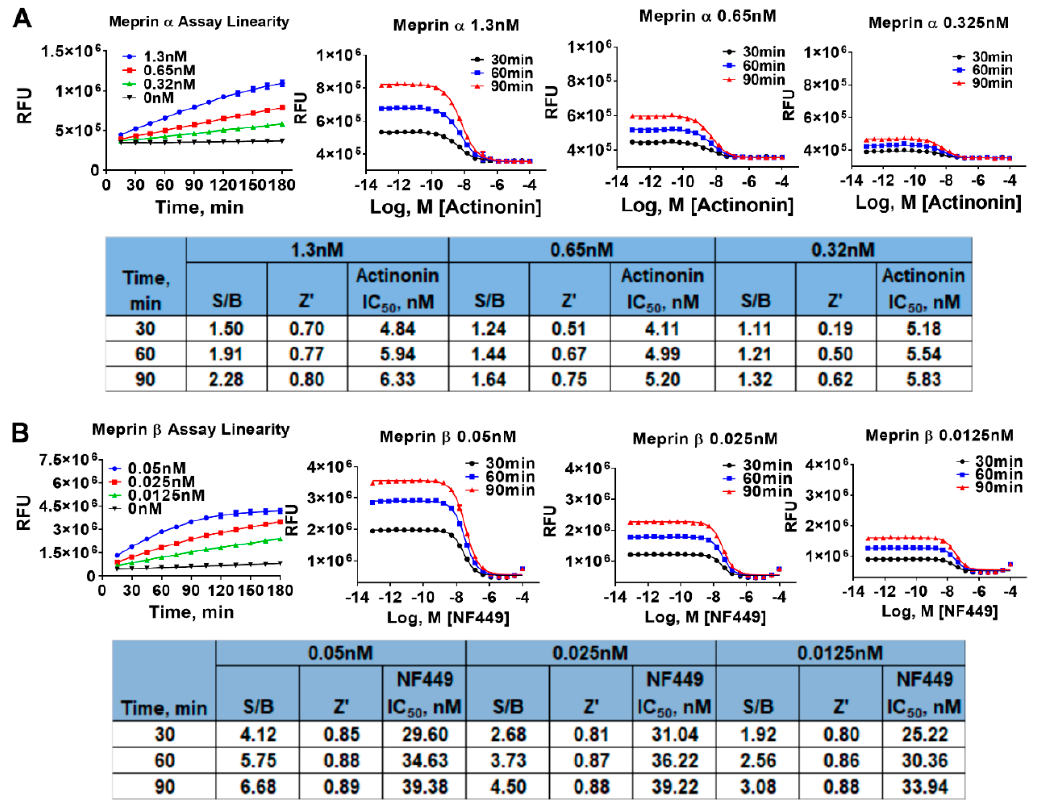
Figure 3. Enzyme concentration and time of reaction optimization experiments in 1536 wpf. ( A ) Meprin α 1536 wpf assay optimization study. ( B ) Meprin β 1536 wpf assay optimization study. Experiments repeated twice, n=4. S/B-signal-to-basal ratio.